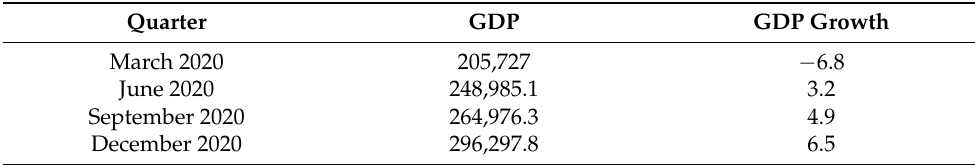
Table 1. China’s quarterly GDP growth during